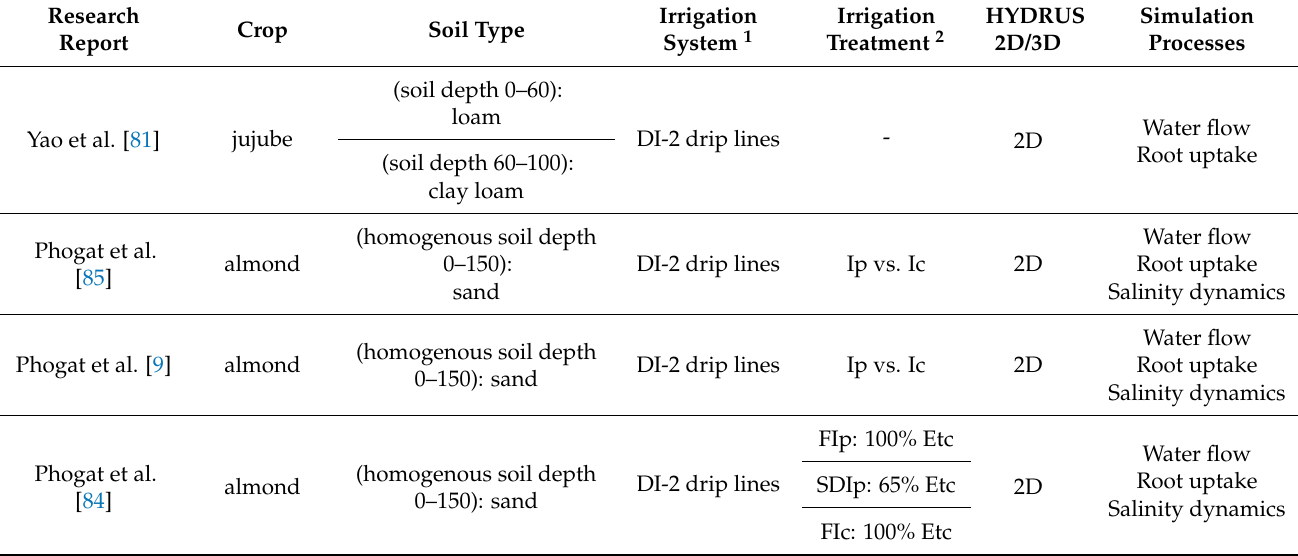
Table 4. Summary of HYDRUS 2D/3D simulations in deciduous